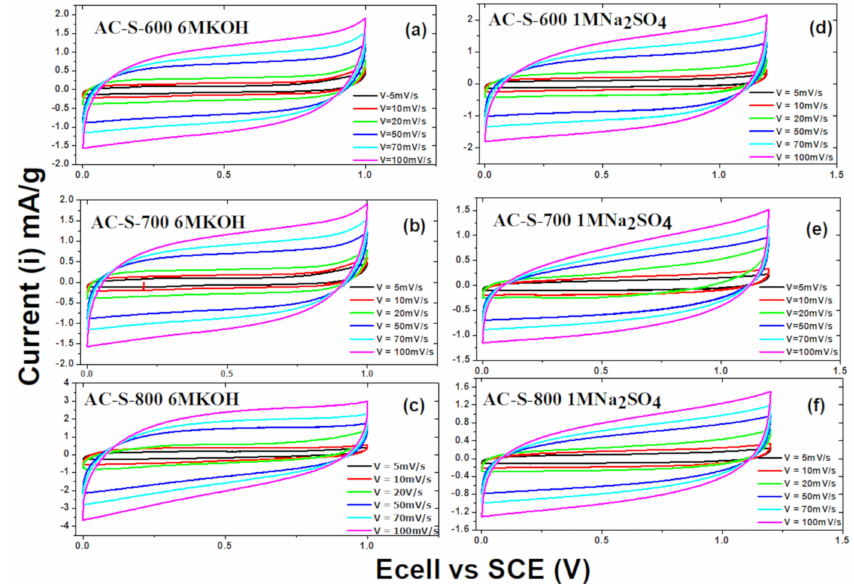
Figure 7. Cyclic Voltammetry (CV) curves of AC-S-600, AC-S-700 and AC-S-800 electrode materials at di ff erent scan rates with 6 M KOH ( a – c ) and 1 M Na 2 SO 4 ( d – f ) as electrolytes.